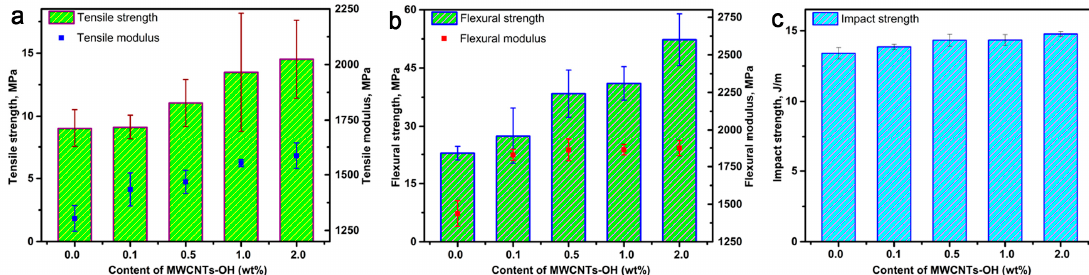
Figure 6. ( a ) Tensile properties, ( b ) flexural properties, and ( c ) impact properties of the nanocomposite bioplastics.